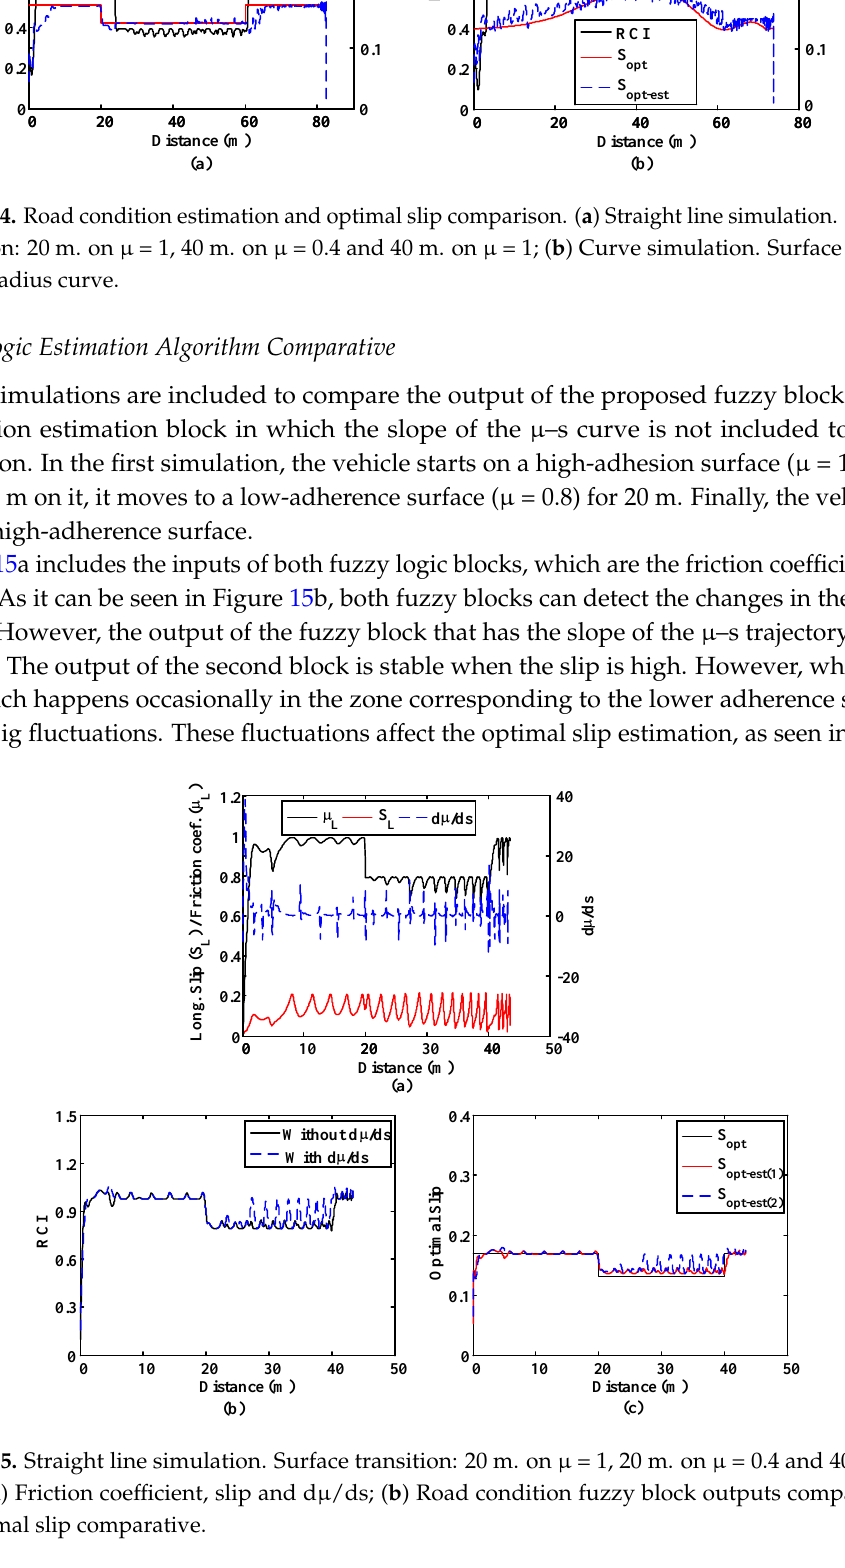
18 Figure 13. Curve simulation. Surface μ = 0.8. 500 m. radius curve. Slip angle comparison. Finally, the road condition and the optimal slip for both simulations are included in Figure 14. It can be seen that the road condition estimation algorithm can detect sudden changes in the adhesion